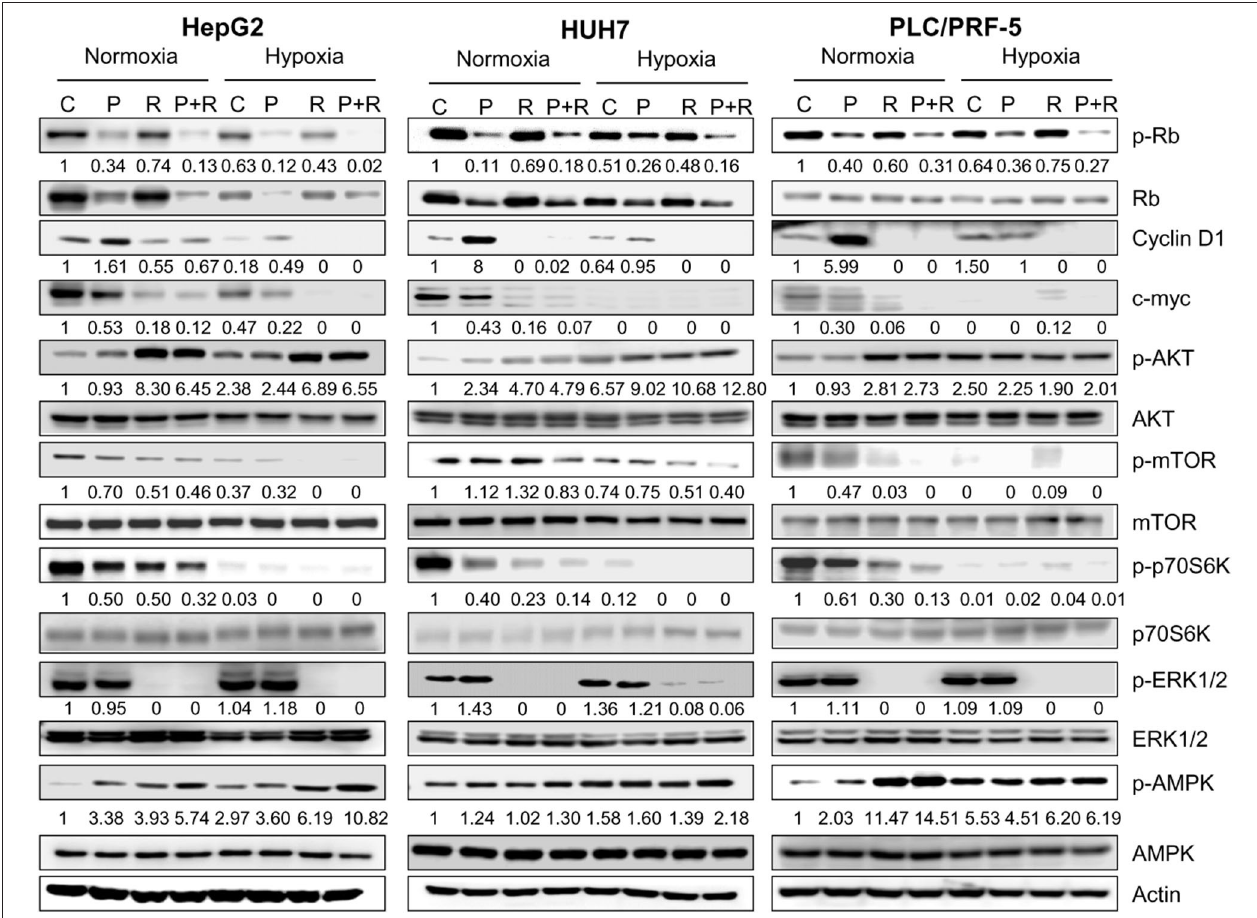
FIGURE 4 | Effects of palbociclib and regorafenib simultaneous combination on the activation/expression of cell cycle regulatory proteins and intracellular signaling pathways. HepG2, HUH7, and PLC/PRF-5 cells were treated with 1 µ M P or 1, 1.5, or 7 µ M R, respectively, as single treatment or in combination under normoxic and hypoxic conditions for 24h. The cells were lysed and the expression of the indicated proteins was evaluated by Western blot analysis. The results are representative of two independent